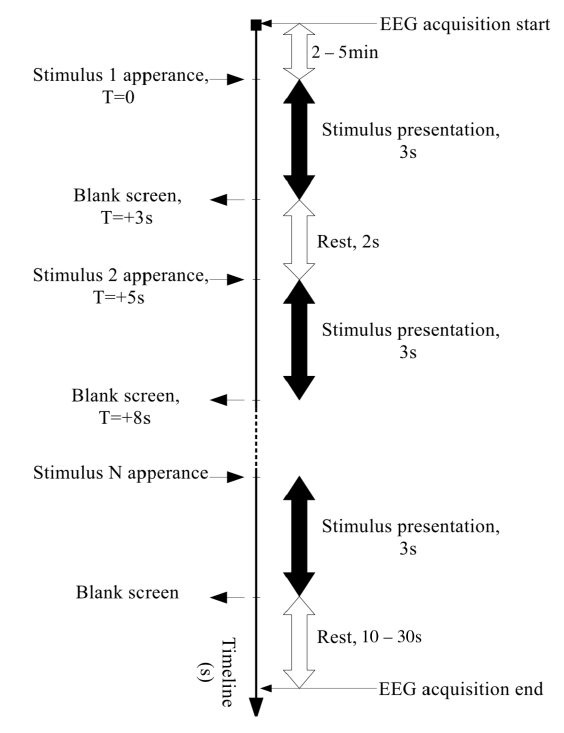
Figure 3. Experiment time